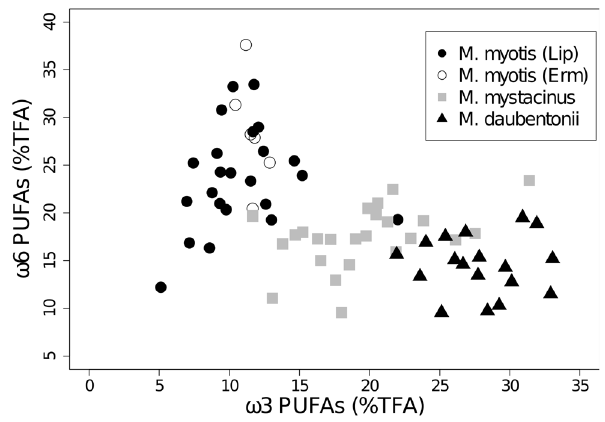
Figure 5. v 6 PUFAs versus v 3 PUFAs per species. Total v 6 PUFAs plotted against total v 3 PUFAs for Myotis myotis (n=29), M. mystacinus (n=24) and M. daubentonii (n=18), TFA= % of total fatty acid. Erm: Ermatingen, Lip: Lipperswil.